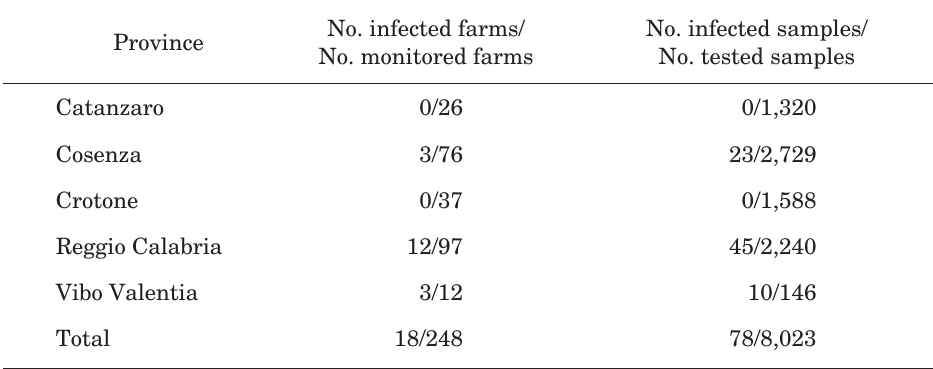
Table 1. Citrus tristeza virus monitored in citrus orchards of Calabrian provinces.